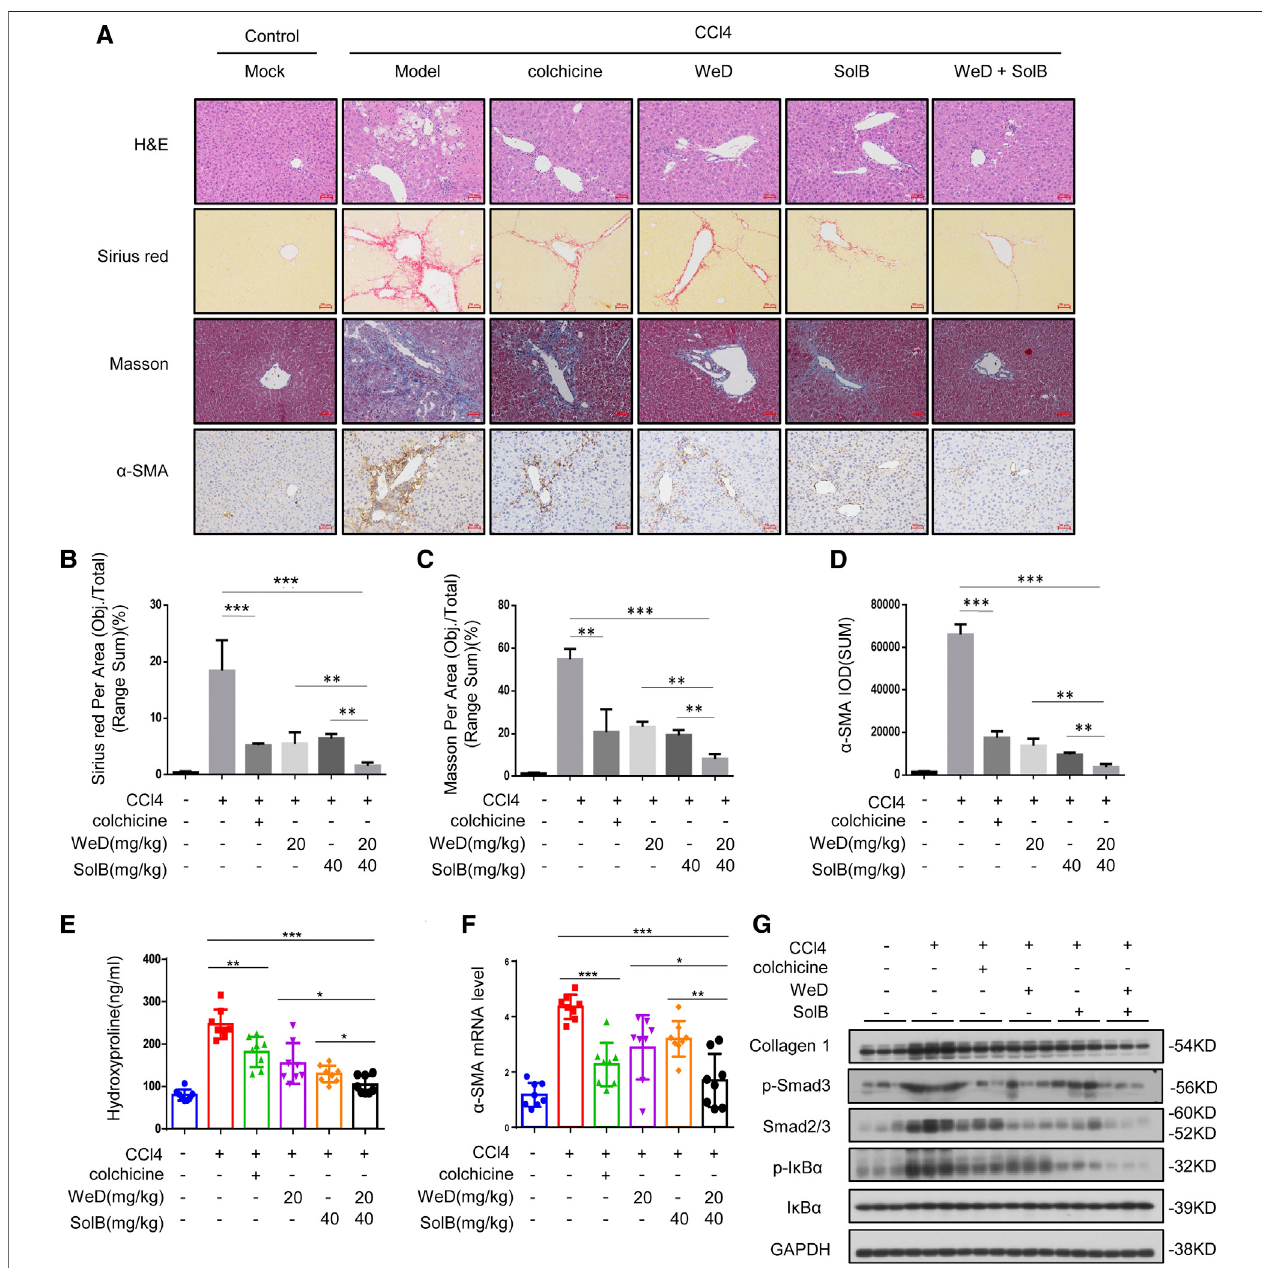
FIGURE 5 | A combination of SolB and WeD treatment dramatically inhibits hepatic fi brosis and injury in CCL4-induced hepatic fi brosis mice. (A) Images of livers from control, CCL4-induced hepatic fi brosis mice, CCL4-induced hepatic fi brosis mice treated with colchicine(0.2 mg/kg), SolB(40 mg/kg), WeD(20 mg/kg) or combination of SolB(40 mg/kg) and WeD(20 mg/kg). Representative micrographs of liver H&E staining, Sirius red, Masson and α -SMAstaining were shown. Scale bars represent 50 μ m. (B – D) Quantitative results of Sirius red (B) , Masson (C) and α -SMA (D) staining sections. (E) Serum level of hydroxyproline of control, CCL4- induced hepatic fi brosis mice, CCL4-induced hepatic fi brosis mice treated with colchicine(0.2 mg/kg), SolB(40 mg/kg), WeD(20 mg/kg) or combination of SolB and WeD. (F) QuantitativePCRanalysisofmRNAlevelsof α -SMAinliversfromcontrol,CCL4-inducedhepatic fi brosismice,CCL4-inducedhepatic fi brosismicetreatedwith colchicine(0.2 mg/kg),SolB(40 mg/kg),WeD(20 mg/kg)orcombinationofSolBandWeD. (G) WesternblotanalysisofCollagen1,p-Smad3,Smad2/3,p-I κ B α ,I κ B α and GAPDH in livers from control, CCL4-induced hepatic fi brosis mice, CCL4-induced hepatic fi brosis mice treated with colchicine(0.2 mg/kg), SolB(40 mg/kg), WeD(20 mg/kg) or combination of SolB and WeD. Data are expressed as Mean ± SD (n (cid:1) 8 or 3 mice). Statistics differences were analyzed using One-way ANOVA followed by Tukey ’ s post hoc tes: * p < 0.05, ** p < 0.01, *** p < 0.001. NS, no signi fi cance.